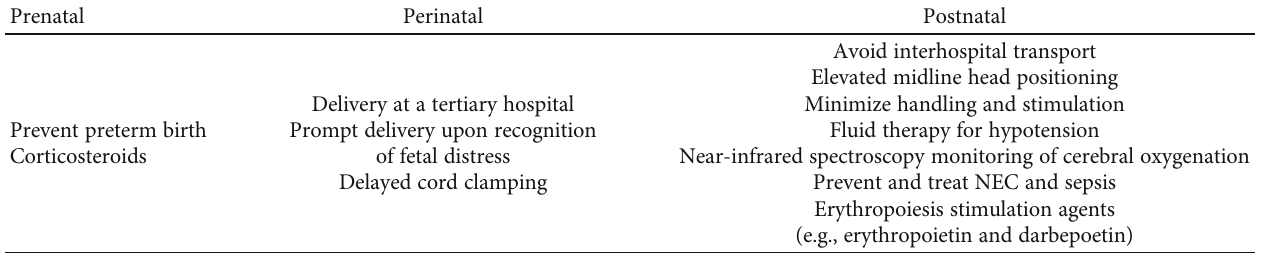
Table 2: Strategies for prevention of GM-IVH in preterm